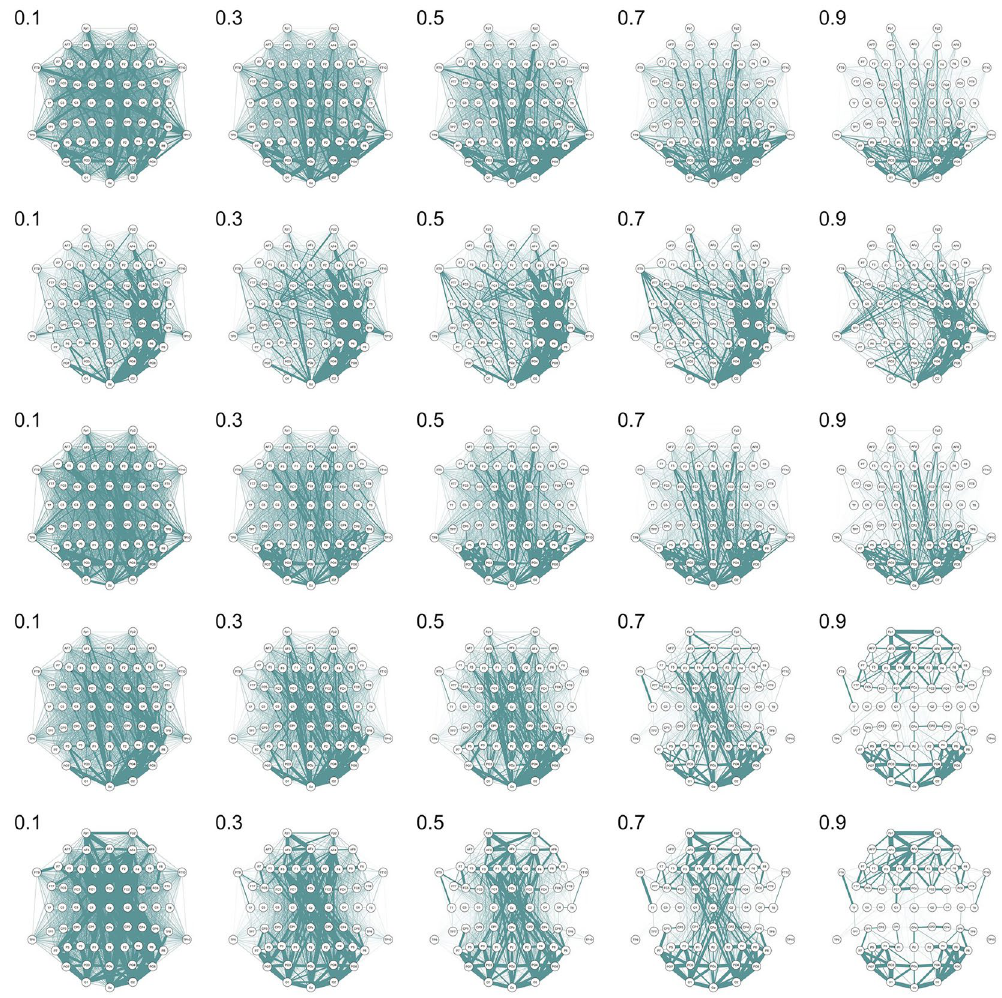
Figure 5. Edge probability graphs across different thresholds in sensor space. The thickness of edges reflects the relative probability of edge existence. Thicker edges are more frequent in the individual networks in the sample. The edge weights were scaled to the range [0, 1] across all thresholds. From top to bottom: wPLI, Imcoh, ciPLV, Coherence, PPC. Qgraph 1.9.2 (https:// CRAN.R- proje ct. org/ packa ge= qgraph) was used to create this